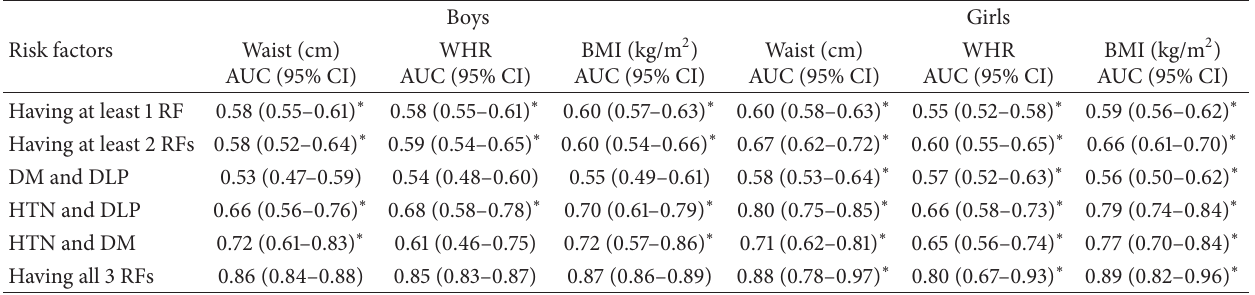
Table 3: Calculated areas under the ROC curves for the studied risk factors in both